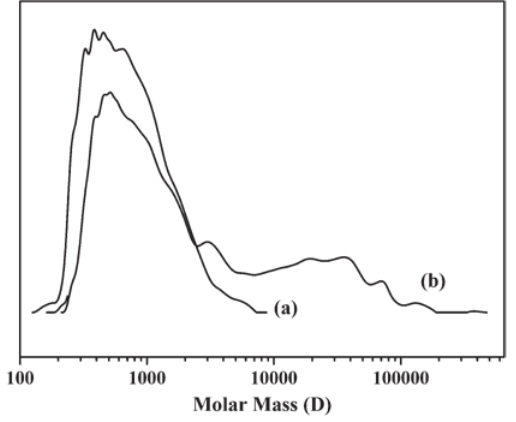
Fig. 1: GPC curves of (a) HPCS and (b) HPBCS.